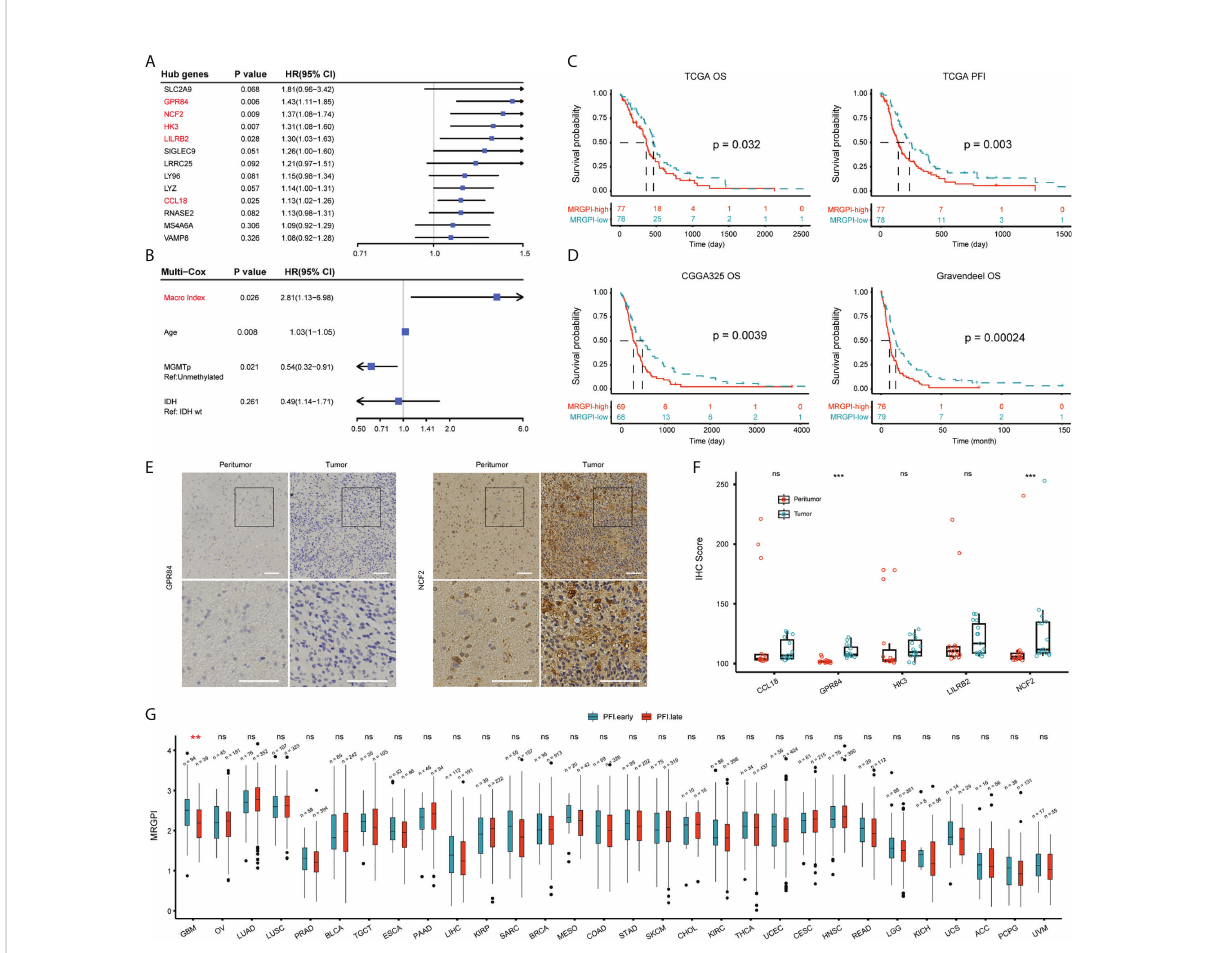
FIGURE 2 Prognostic signi fi cance of MRGPI-based groups. (A) Multivariate Cox regression analysis of 13 differentially expressed macrophage-related hub genes. (B) Cox regression analysis of the MRGPI and clinicopathological parameters based on the TCGA cohort. Covariates including age, gender, IDH mutation, ATRX mutation, MGMT promoter methylation status, TERT promoter mutation, and MRGPI were included in the initial univariate Cox regression. Covariates with p-values less than 0.01 were further included in the multivariate Cox model. (C, D) K-M analysis of the survival and tumor progression-free interval differences between MRGPI-based groups based on TCGA, CGGA325, and Gravendeel GBM cohorts. (E, F) Immunohistochemical staining of fi ve genes at the protein level. The tissue was divided into core of the tumor (Tumor) and the margin containing in fi ltrating tumor cells (Peritumor) in three patients with a pathological diagnosis of GBM. The intensity of staining for the proteins encoded by these genes at the tissue level ranged from negative to positive, with E showing genes with signi fi cantly higher IHC scores in the tumor core. The IHC scores of the fi ve genes were shown in F (Scale bar, 100 m m). (G) Pan-cancer-based MRGPI prognostic signi fi cance. Samples were split into early (PFI < 6 months) and late (PFI > 12 months) relapse groups based on PFI. OV, Ovarian serous cystadenocarcinoma; LUAD, Lung adenocarcinoma; LUSC, Lung squamous cell carcinoma; PRAD, Prostate adenocarcinoma; BLCA, Bladder urothelial carcinoma; TGCT, Testicular germ cell tumors; ESCA, Esophageal carcinoma; PAAD, Pancreatic adenocarcinoma; LIHC, Liver hepatocellular carcinoma; KIRP, Kidney renal papillary cell carcinoma; SARC, Sarcoma; BRCA, Breast invasive carcinoma; MESO, Mesothelioma; COAD, Colon adenocarcinoma; STAD, Stomach adenocarcinoma; SKCM, Skin cutaneous melanoma; CHOL, Cholangiocarcinoma; KIRC, Kidney renal clear cell carcinoma; THCA, Thyroid carcinoma; UCEC, Uterine corpus endometrial carcinoma; CESC, Cervical squamous cell carcinoma and endocervical adenocarcinoma; HNSC, Head and neck squamous cell carcinoma; READ, Rectum adenocarcinoma; LGG, Lower grade glioma; KICH, Kidney chromophobe; UCS, Uterine carcinosarcoma; ACC, Adrenocortical carcinoma; PCPG, Pheochromocytoma and paraganglioma; UVM, Uveal melanoma. ***p < 0.001. ns, non signi fi